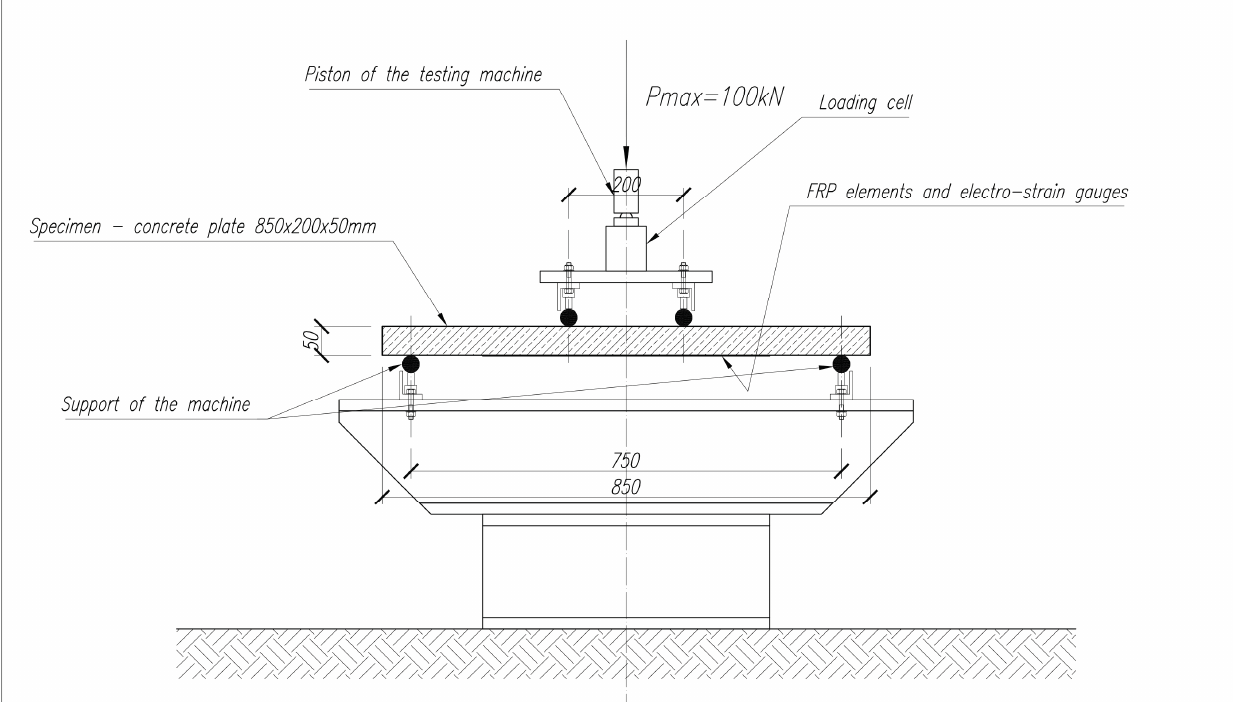
Figure 4. Scheme of the laboratory flexural strength-loading test of concrete slabs, with dimensions in